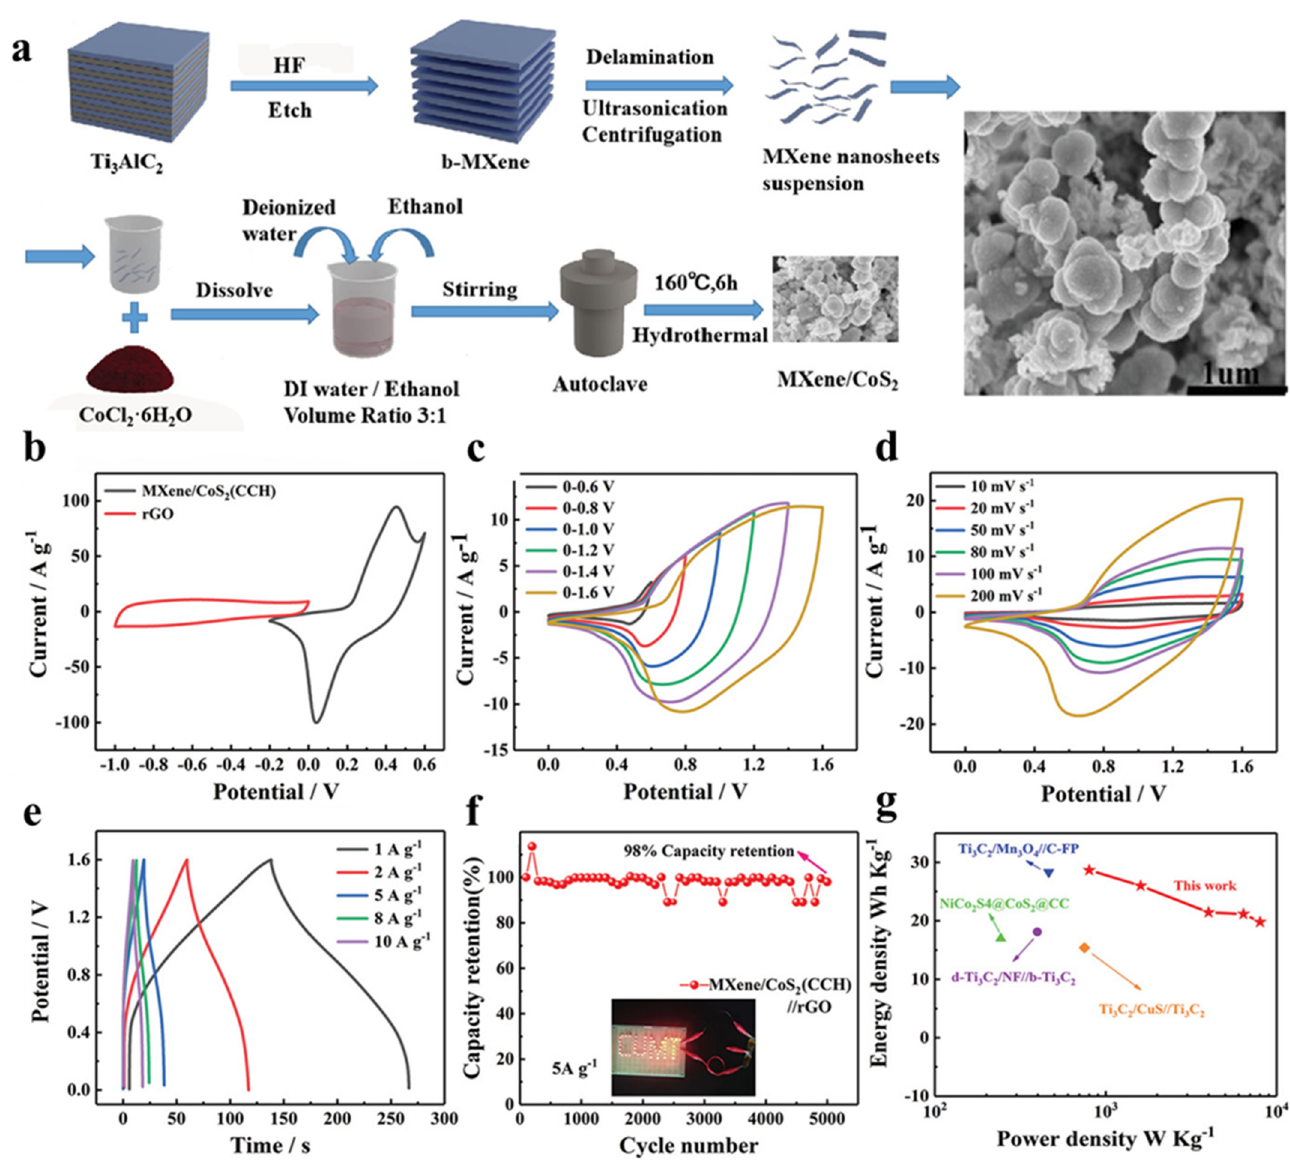
Figure 19. ( a ) Schematic diagram for the synthesis process of MXene/CoS 2 (CCH) composite with the ( b ) SEM image, and the ( b – g ) electrochemical performance of MXene/CoS 2 (CCH)//rGO ASCs in 2 M KOH aqueous electrolyte. [148].